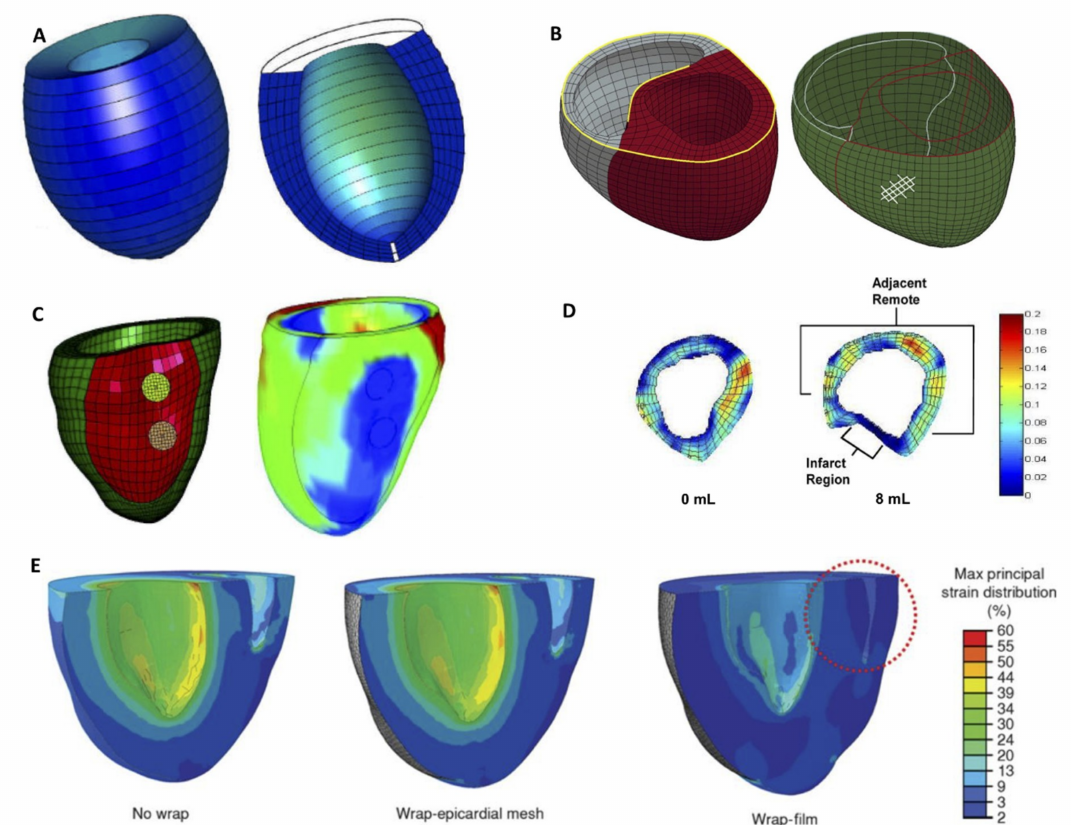
Figure 2. Finite element analysis (FEA)of ventricular support. ( A ) Three-dimensional FEA mesh of a dilated canine left ventricle (LV) in the unloaded state with a cross-sectional view of the interior cavity and wall (modified and reprinted from [51] with permission from Elsevier). ( B ) Biventricular FEA model with LV in red and right ventricle (RV) in grey (yellow lines are fully constrained). The green shell elements represent the Acorn cardiac support device (white lines on outside represent fiber orientations). Modified and reprinted from [52], with permission from Elsevier. ( C ) The Coapsys model showing the double pad side of the device. Infarct regions are colored with red while the remote regions are colored with green, myofiber stress at end systole in the virtual Coapsys model, showing a reduction of stress (in the blue area) compared to the control. Modified and reprinted from [55], with permission from Elsevier. ( D ) Device filling (8 mL) altered both the geometry and strain in the basal region where the device was positioned. Modified and reprinted from [18], with permission from Elsevier. ( E ) Maximum principal strain distribution without any wrap (left), with the epicardial mesh wrap (middle), and with the film wrap (right). Encircled area indicates RV collapse. Modified and reprinted from [37], with permission from the American Association for the Advancement of